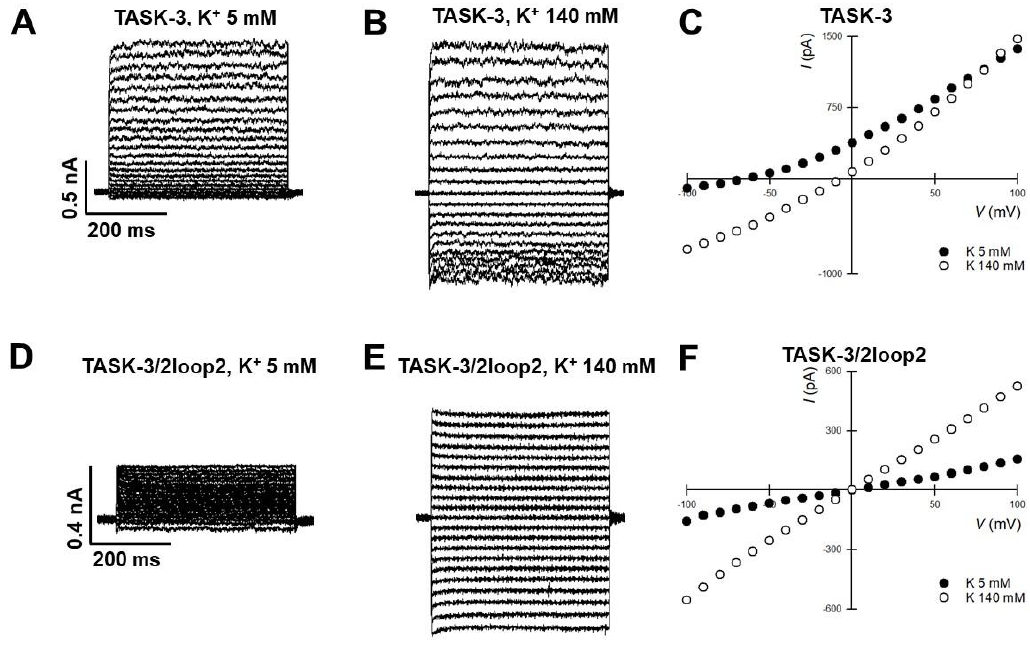
Figure 4. Functional evaluation of TASK-3/2Loop2 construct: effect on rectification, time-dependence and selectivity. Representative whole-cell recordings of TASK-3 ( A , B , n = 6) and TASK-3/2Loop2 ( D , E , n = 6) K + -mediated currents recorded according to the voltage protocol described in the legend of Figure 1. The results in ( A – C ) correspond to TASK-3 WT channels and those in ( D – F ) to TASK-3/2loop2 construct. In ( A , D ), the extracellular medium was 135 mM Na + and 5 mM K + . In ( B , E ), the extracellular Na + was replaced by an equimolar amount of K + (140 mM). ( C , F ) shows the representative current-voltage relations for TASK-3 and 2loop2 channels under different extracellular K + concentrations (closed circles 5 mM; open circles 140 mM).